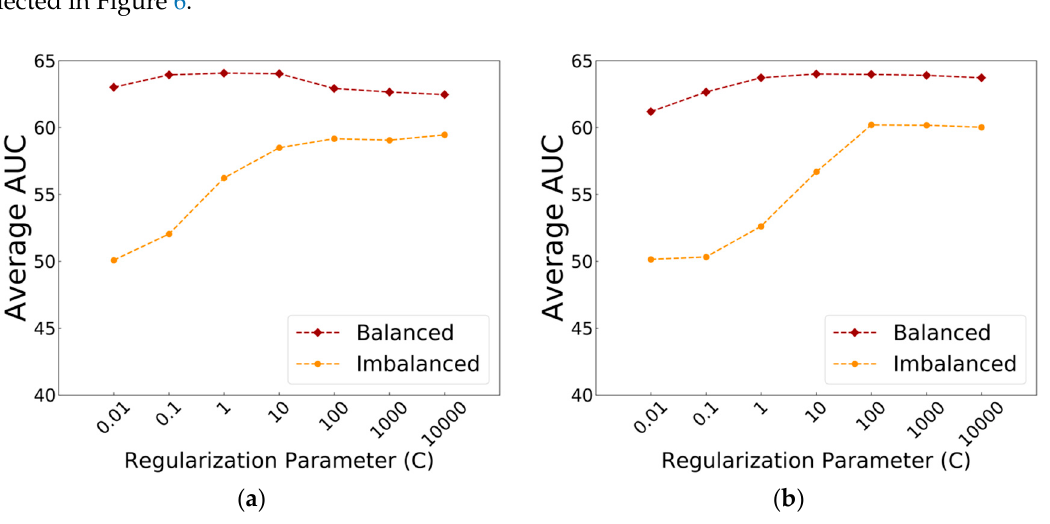
Figure 6. Average AUC when the value of C is changed in classification via: ( a ) SVM; ( b ) LR.